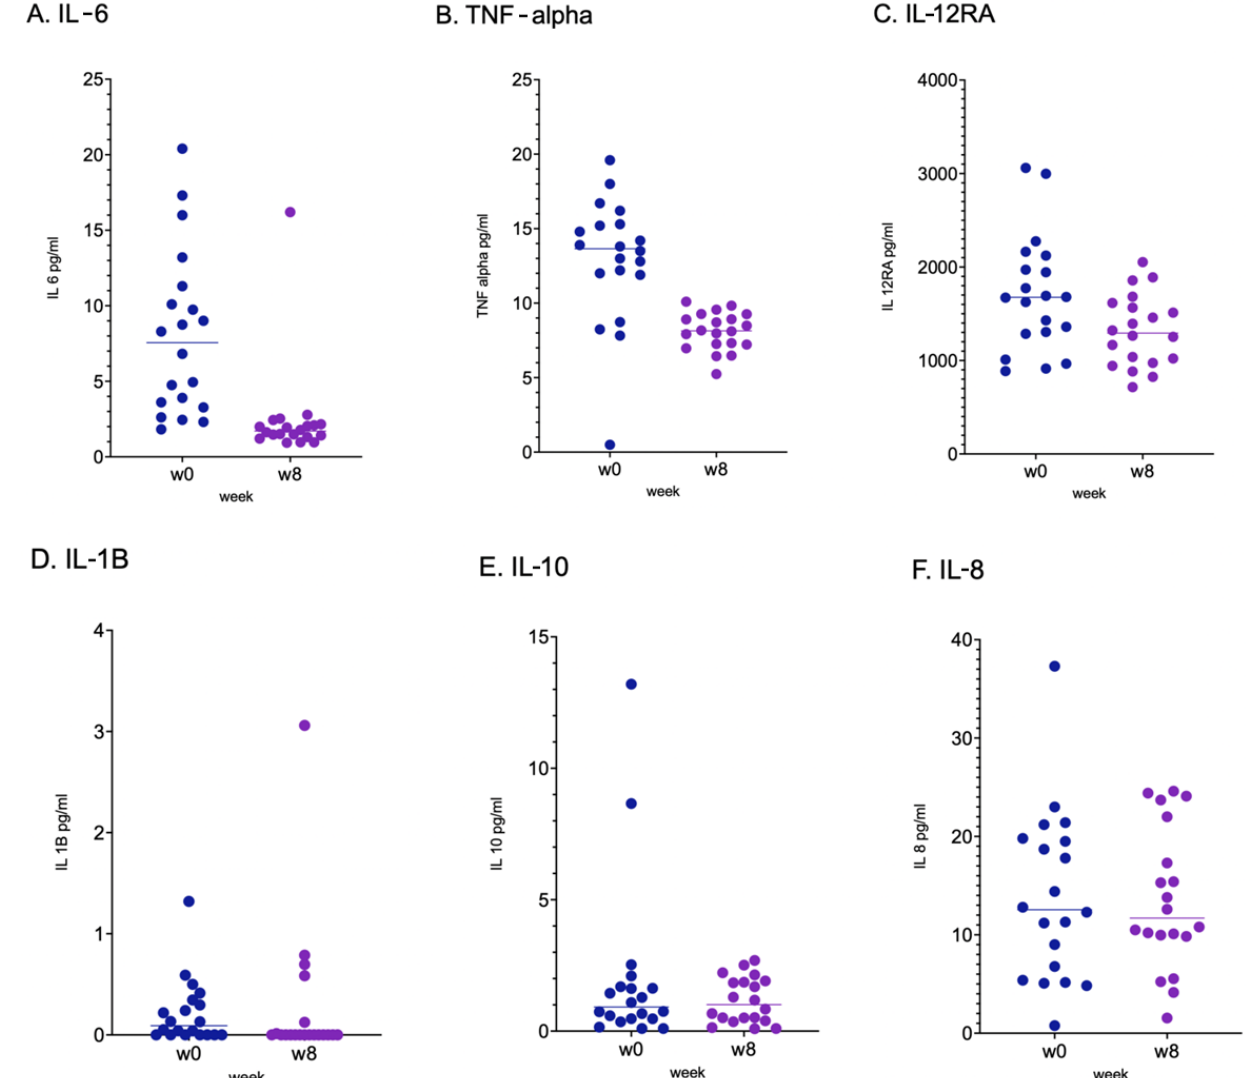
Figure 1. Values of cytokines detected at baseline (Week 0, W0) and at the end of the study (Week 8, W8). p values for IL-6 ( A ), TNF-α ( B ) and IL-12RA ( C ) were p < 0.001 and p < 0.02, respectively. p values for IL-1B ( D ), IL-10 ( E ) and IL-8 ( F ) were not significant. Paired data were compared by Wilcoxon test after verification of non normal distribution by graphical qqplot representation. The comparisons are reported at T 0 (Week 0, w0) and T 1 (Week 8, w8), Serum levels of citrulline were significantly reduced at the end of treatment (107.14